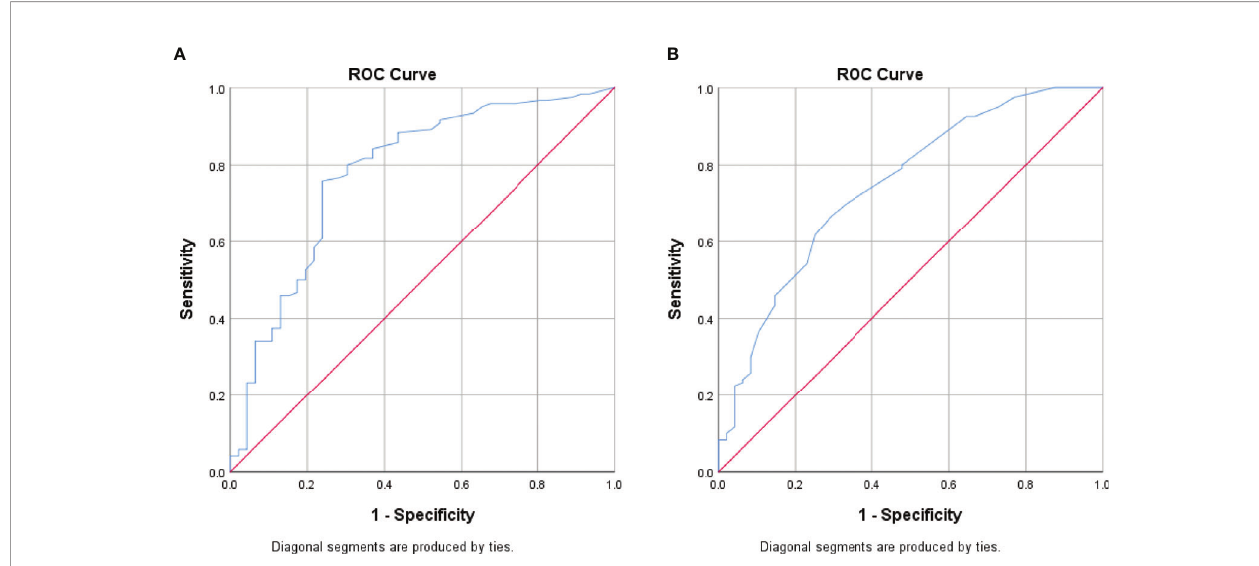
FIGURE 3 | (A) Receiver operating characteristic (ROC) curve analysis of the SUV max of lymph nodes. (B) ROC curve analysis of lymph node